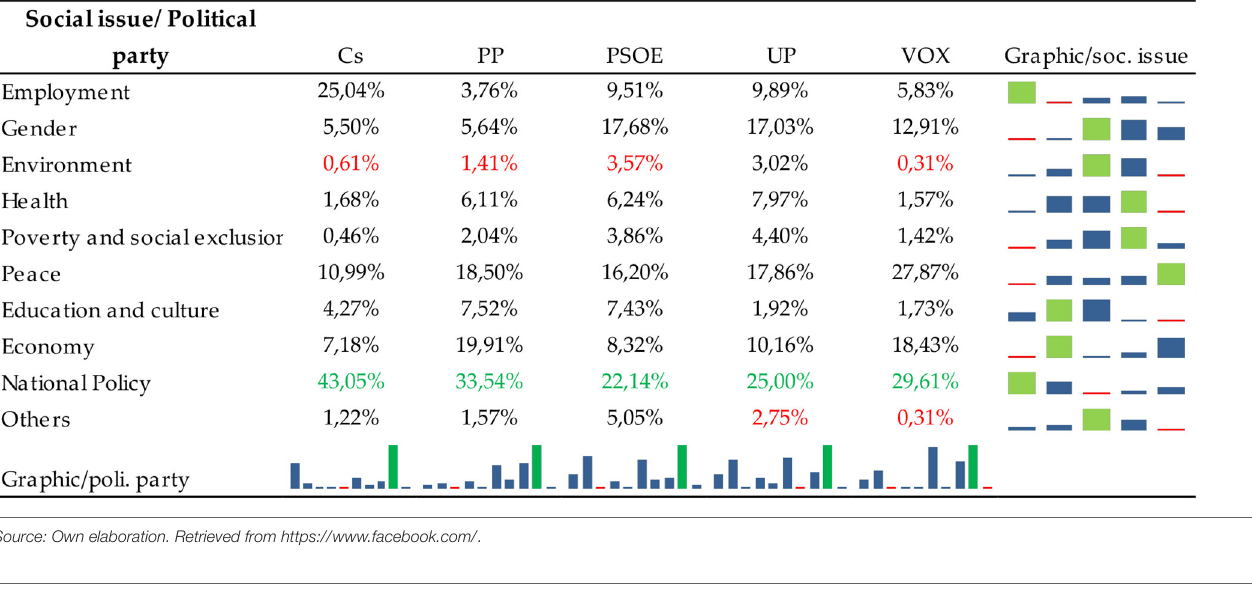
TABLE 8 | Impact (likes + comments) of messages that address social issues in each